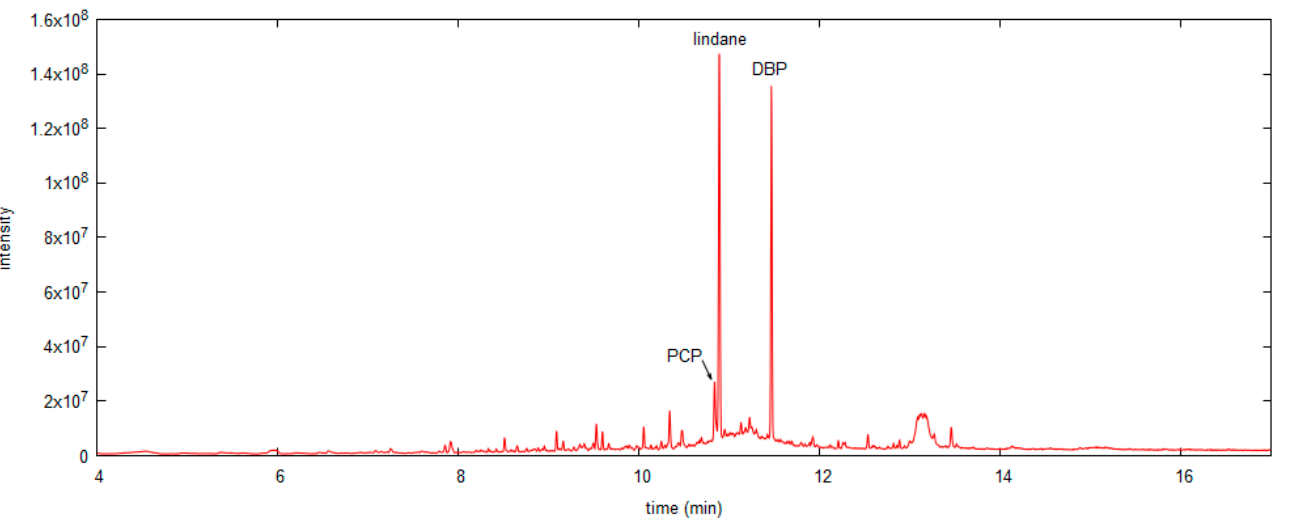
PCP signal was present in the GC–MS chromatograms at the noise level, but a character-